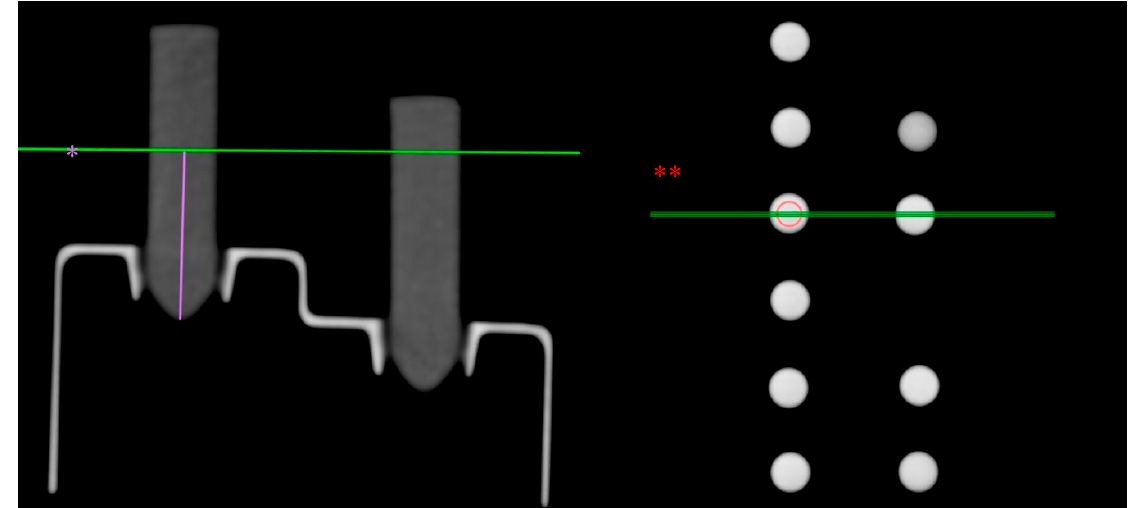
Figure 2. Experimental set-up in Computed Tomography (CT) scans. Measurement of a sample at height R1 in sagittal plane (*); region of interest (ROI) cursor in axial plane (**).